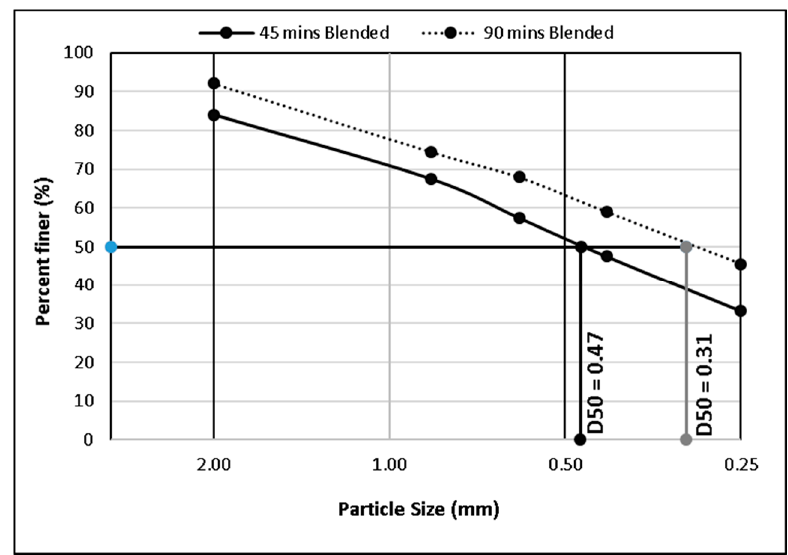
Figure 4. Particle size distribution, showing the variation in D50 as a function of the compounding time.